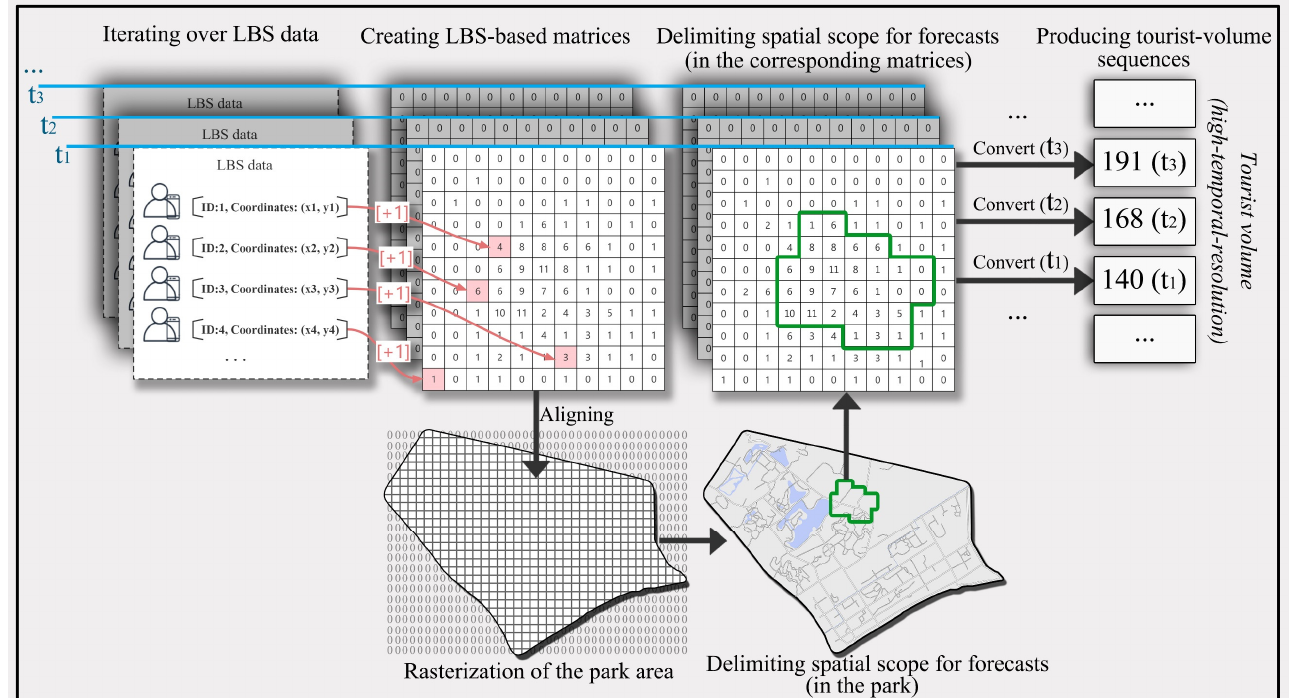
Figure 1. Illustration of the control mechanism for forecasting scope.